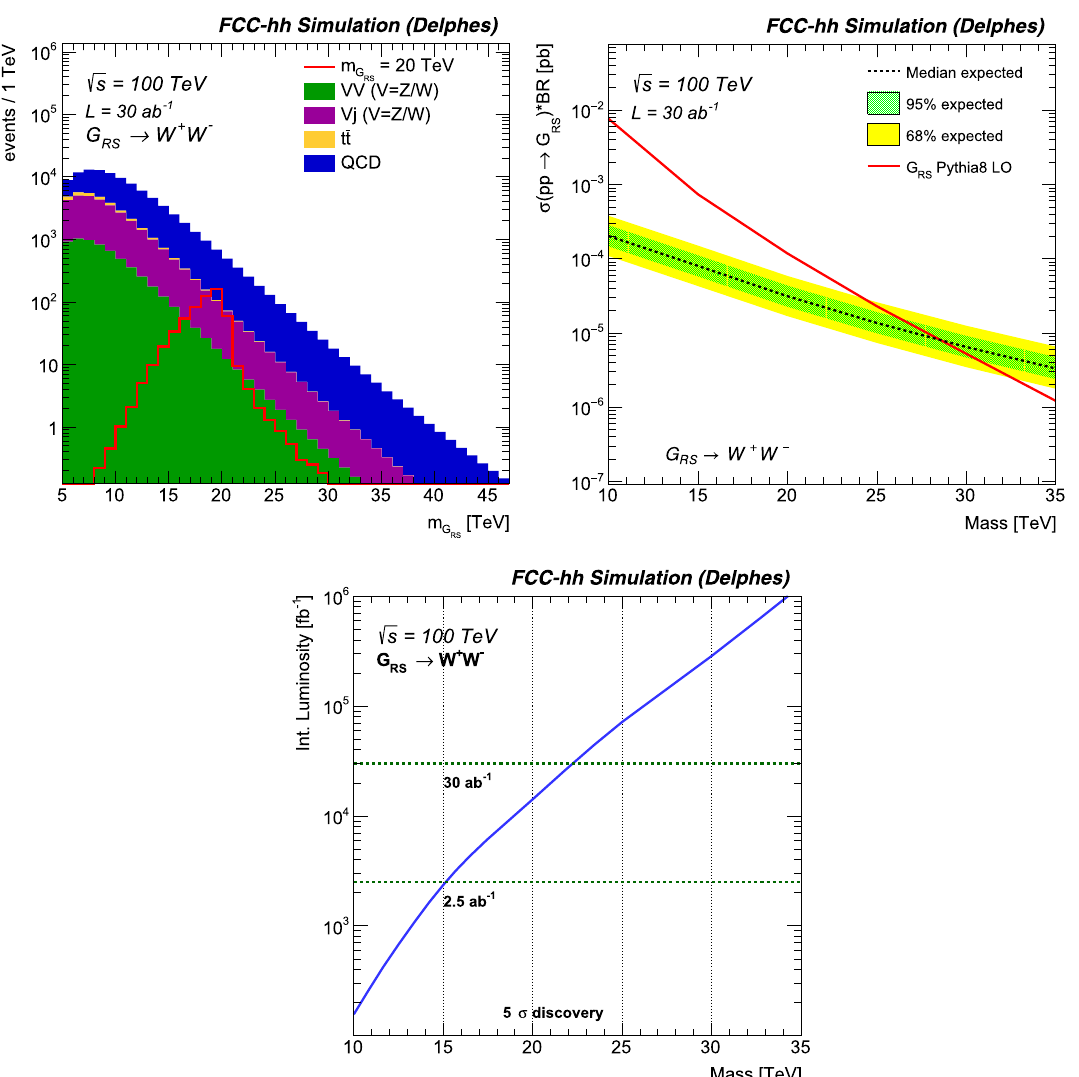
Fig. 9 Invariant mass distribution of the two selected W-jets for a 20TeV signal (left), 95% CL limit versus mass (right) and 5 σ discovery reach (bottom)